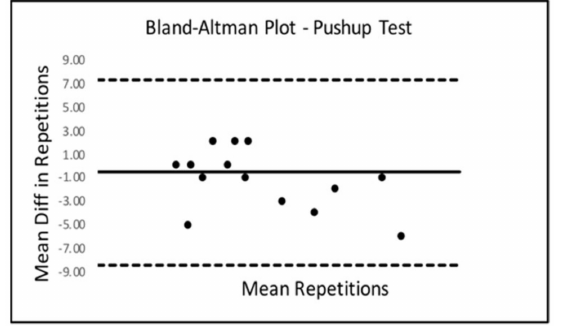
Figure 4. Bland–Altman Plot—Pushup.